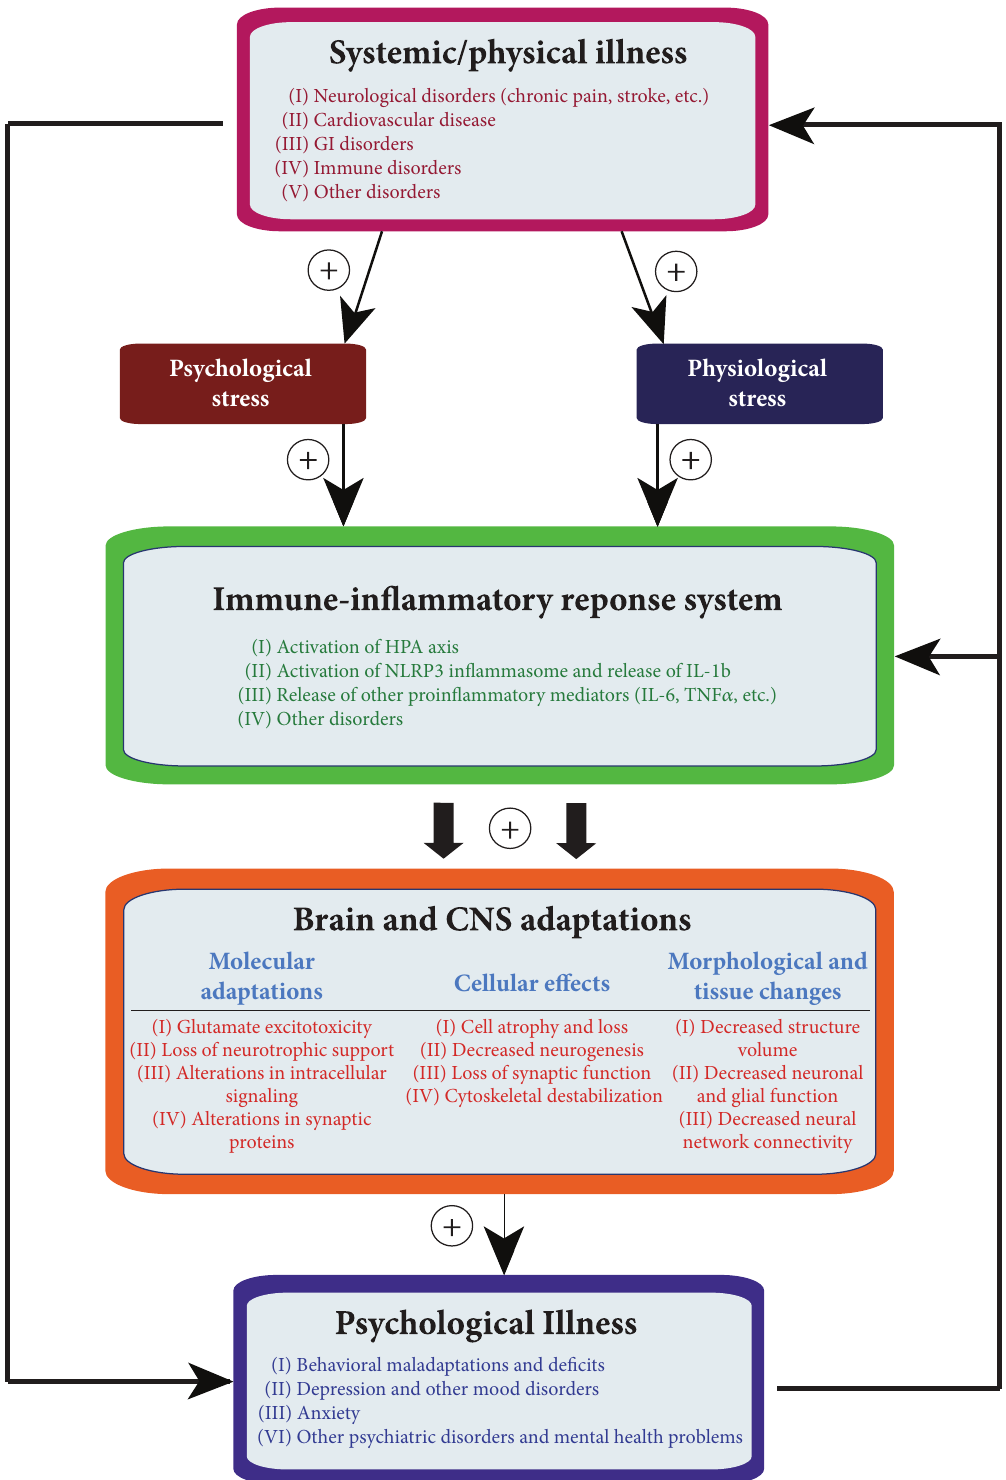
Figure 1: Bidirectional relationship between systemic illness and psychiatric disorders. Physical and/or psychological stress associated with systemic illness can lead to activation of immune response system resulting in increased local and systemic release of proinflammatory cytokines. Increased levels of inflammatory mediators in the CNS are potentially key contributors to the damaging cellular and morphological adaptations that underlie development of comorbid mental